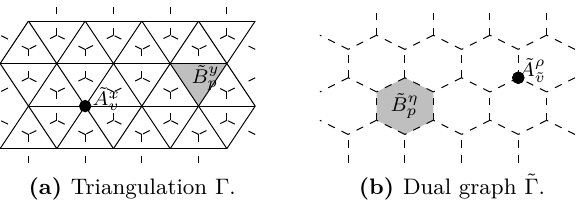
Figure 10 . (a) The operators ˜ A x ˜ A ρ , ˜ B η defined on the dual graph ˜Γ . ˜ v ˜ p